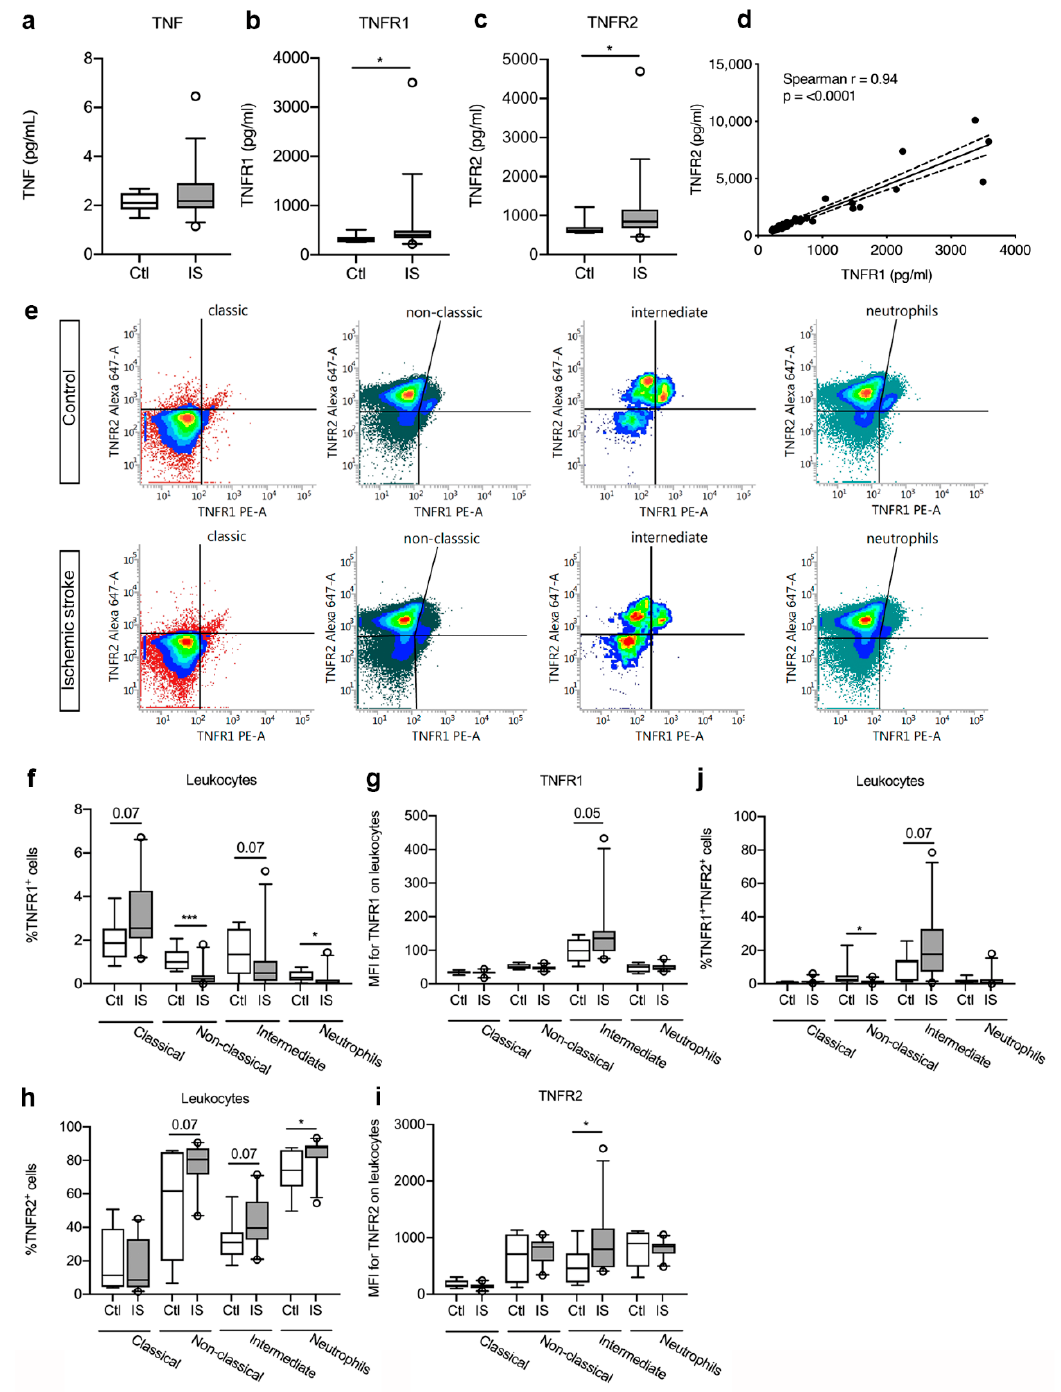
Figure 3. Characterization of TNFR1 and TNFR2 levels and cellular expression in ischemic stroke (IS) patients. ( a – c ) Electrochemiluminescence analysis of TNF ( a ), TNFR1 ( b ), and TNFR2 ( c ) plasma concentrations in IS patients ( n = 33) and healthy controls (Ctl, n = 10), demonstrating significantly increased TNFR1 and TNFR2 plasma levels in IS patients compared to healthy Ctl. ( d ) Correlation analysis of TNFR1 and TNFR2 plasma levels in IS patients ( n = 44), demonstrating a significant positive correlation between TNFR1 and TNFR2 levels post-stroke ( p < 0.0001). Line: linear regression through the data points. Dotted line: 95% confidence interval of linear regression. ( e ) Flow cytometry analysis of TNFR1 and TNFR2 expression on classical monocytes, non-classical monocytes, intermediate monocytes, and neutrophils in IS patients ( n = 23) and healthy Ctl ( n = 8). ( f ) Quantification of the percentage of TNFR1 + monocyte subsets and neutrophils in IS patients and healthy Ctl. ( g ) Mean fluorescence intensity (MFI) of TNFR1 on classical, non-classical, and intermediate monocytes and on neutrophils in IS and healthy Ctl. ( h ) Quantification of the percentage of TNFR2 + monocyte subsets and neutrophils in IS patients and healthy Ctl. ( i ) MFI of TNFR2 on classical, non-classical, and intermediate monocytes and on neutrophils